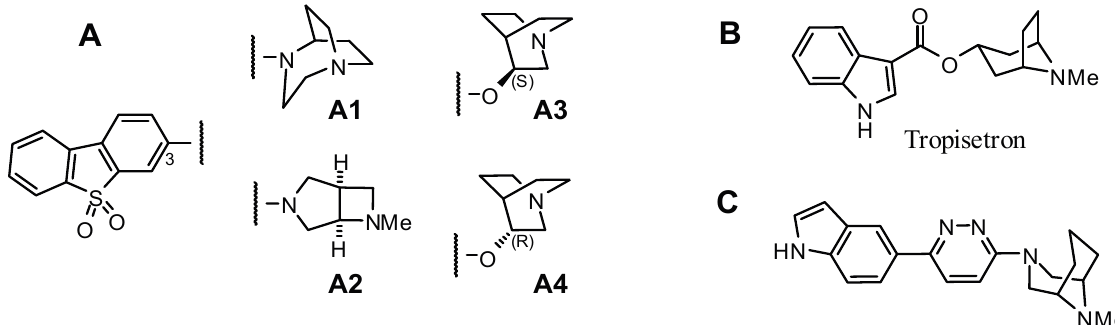
Figure 1. Structures of recent α 7 nAChR ligands. Four examples of bicyclic amines